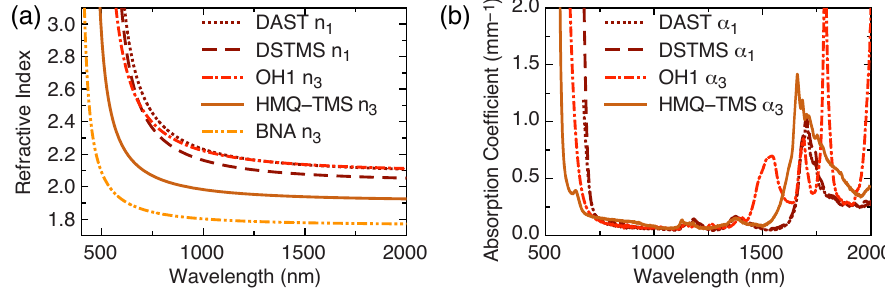
Figure 5. ( a ) refractive index and ( b ) absorption coefficient as a function of wavelength for some of the state-of-the-art organic crystals for light polarized along the polar axis of the particular crystal: